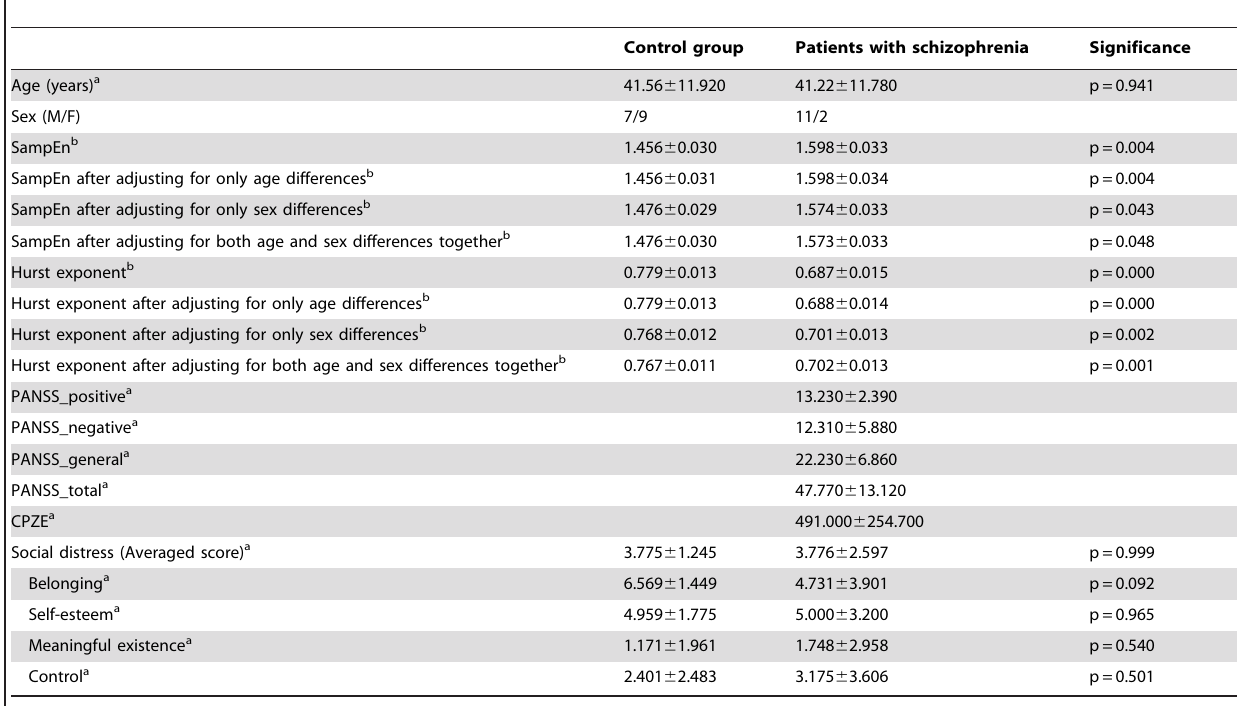
Table 1. Participants’ characteristics, SampEn, Hurst exponent, PANSS, CPZE and Social distress